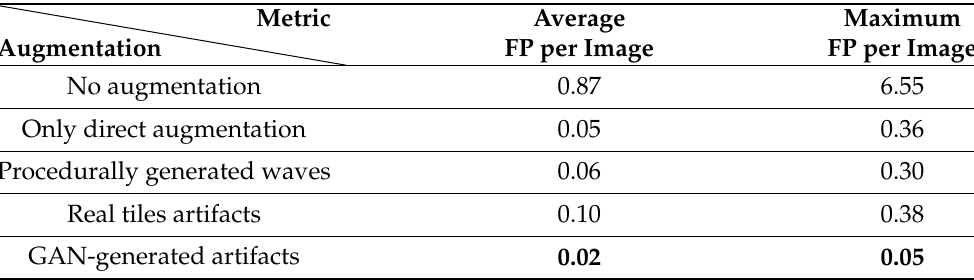
Table 4. Number of falsely predicted particles (FP) per image for datasets containing no particles of interest measured after training with different augmentation methods. The best results are written in